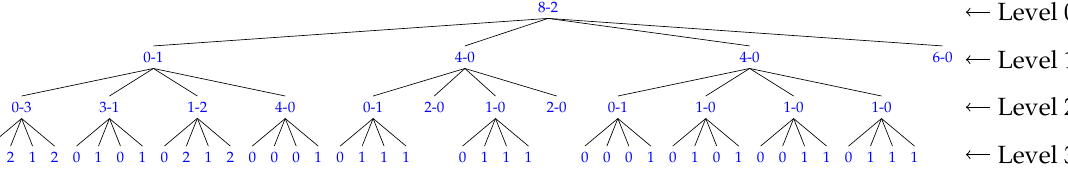
Figure 3. A k 2 -raster ( k = 2) tree storing the maximum and minimum values for each quadrant of every recursive subdivision of the matrix in Figure 2. Every node contains the maximum and minimum values of the subquadrant, separated by a dash. On the last level, only one value is shown as each subquadrant contains only one cell.